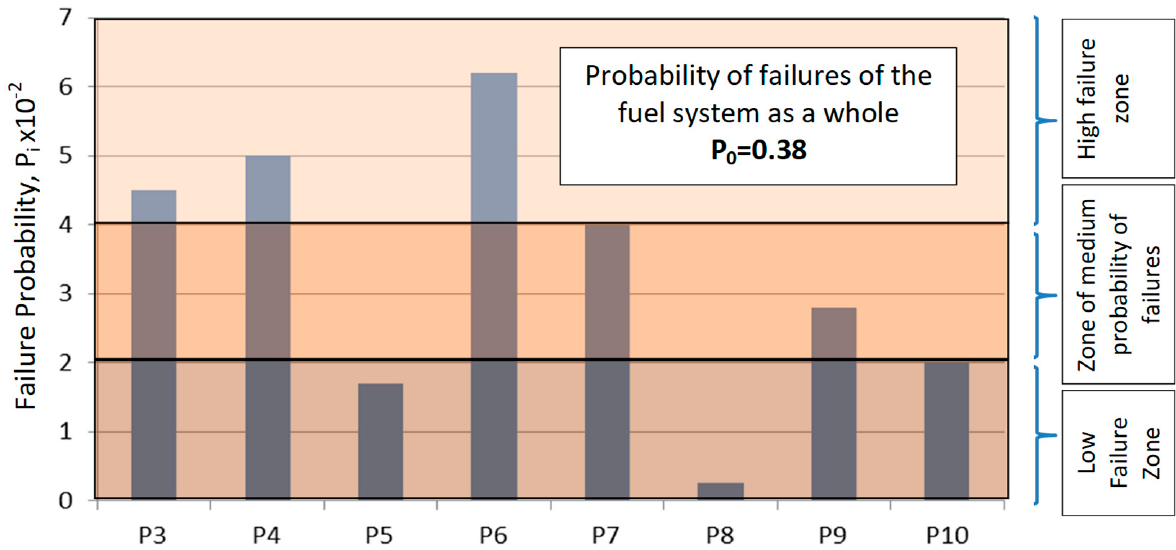
Figure 3. Diagram of failure probabilities of engine fuel system elements with the replacement of structural materials: P 3 —the probability of a fuel tank failure; P 4 —the probability of a booster pump failure; P 5 —probability of filter failure; P 6 —the probability of failure of the high pressure fuel pump; P 7 —probability of injector failure; P 8 —the probability of pipeline failure; P 9 —the probability of valve failure; P 10 —the probability of failure of the seals.